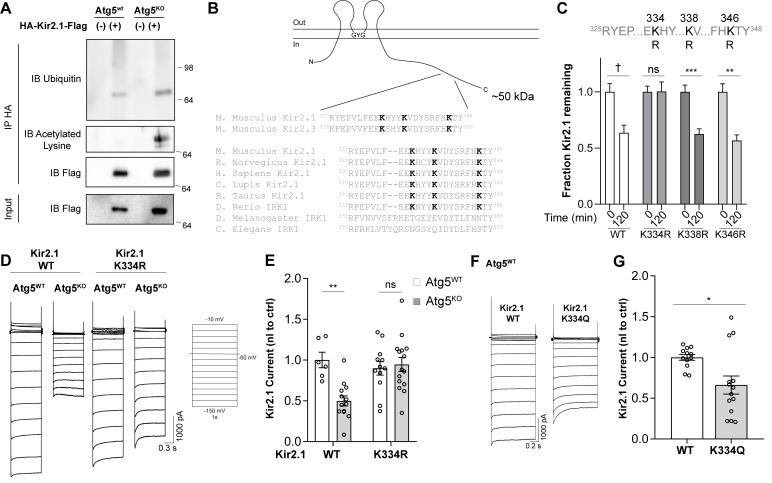
Hyperacetylation of Kir2.1 at K334 in the absence of autophagy inhibits channel activity.(A) Immunoprecipitation of Kir2.1 reveals elevated levels of acetylated lysines on Kir2.1 in Atg5KOMEFs without a change in ubiquitination. Representative blots shown from at least three independent replicates. (B) A conserved motif in the C-terminal tail of Kir2.1 and Kir2.3 contains three modifiable lysines and has previously been implicated in Kir2 channel degradation. (C) A degradation screen in which K334, K338 and K346 were mutated to the unmodifiable residue, arginine, reveals that K334 is required for Kir2.1 degradation in Atg5WT MEFs. N: (T=0min, T = 120 min) WT (52,79), K334R (27,51), K338R (40,41), K346R (23,11). Data analyzed by two-way ANOVA followed by Bonferroni post-hoc test. Kir genotype x time: F(3,390) = 3.211, p = 0.0230. (D-E) Kir2.1 K334R current is normalized in Atg5KO MEFs but does not affect Kir2.1 current in Atg5WT MEFs. Data analyzed by two-way ANOVA followed by Bonferroni post-hoc test. Cell genotype x Kir genotype: F(1,42) = 9.603, p = 0.0035. (F-G) Kir2.1 K334Q, with an acetylation-mimic at K334, has reduced current in Atg5WT MEFs. Voltage step protocol is the same as in (D). Data analyzed by two-tailed unpaired t test. t24=2.707, p=0.0123. ns p>0.05, * p<0.05, ** p<0.01, *** p<0.001, † p<0.0001. Experiments in C, E and G were combined from at least three independent experiments.Figure 8—source data 1.Source Data for Figure 8.